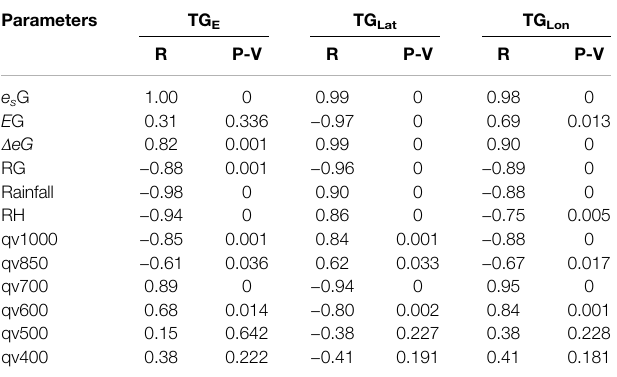
TABLE 6 | The coef fi cients are measured from the correlation evaluation between the gradient of temperatures and climatic